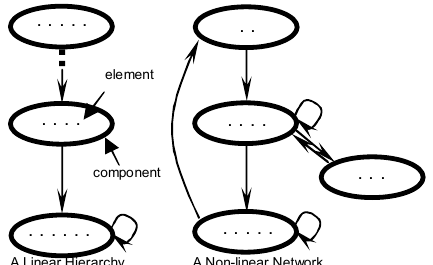
Fig. 2. Structural difference between linear hierarchy and nonlinear